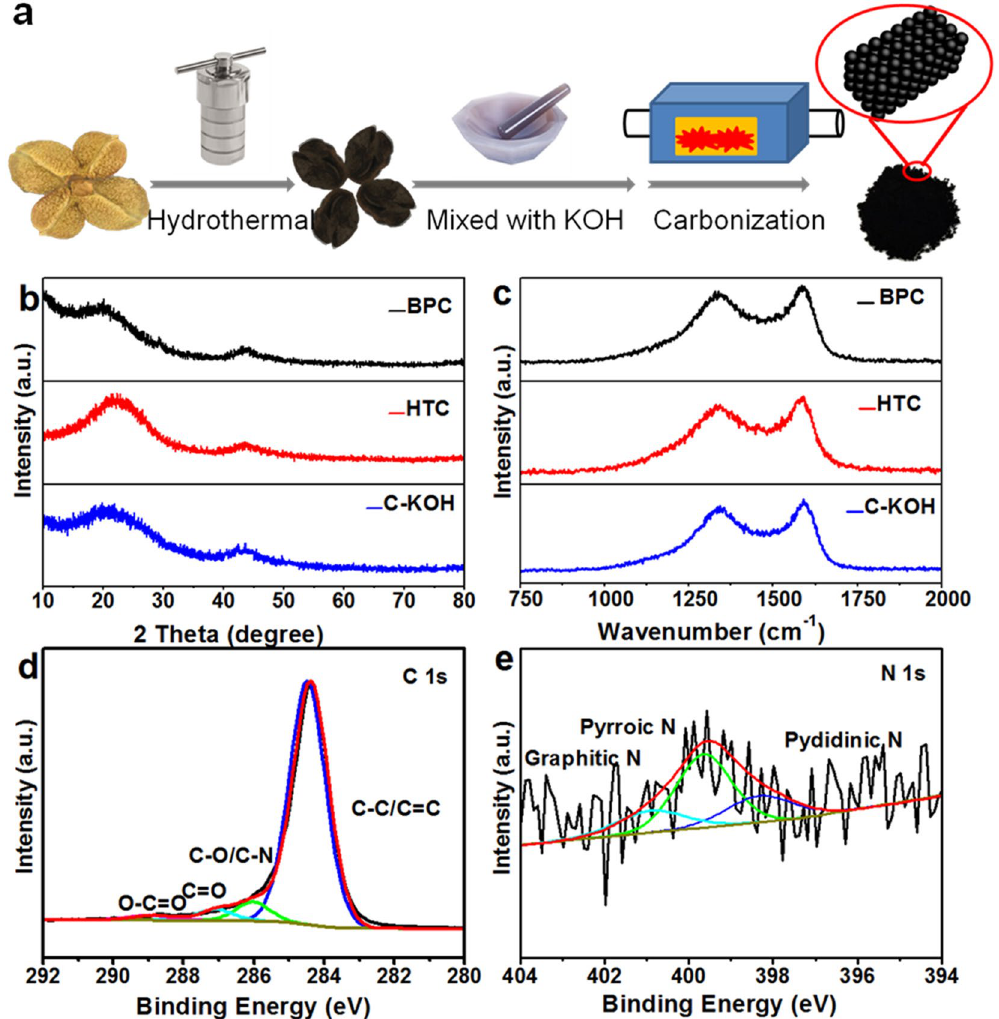
Figure 1. ( a ) Schematic illustration of the formation process of BPC. ( b ) XRD patterns of three samples. ( c ) Raman spectrums of three samples. ( d ) C 1 s XPS spectrum and ( e ) N 1 s XPS spectrum of